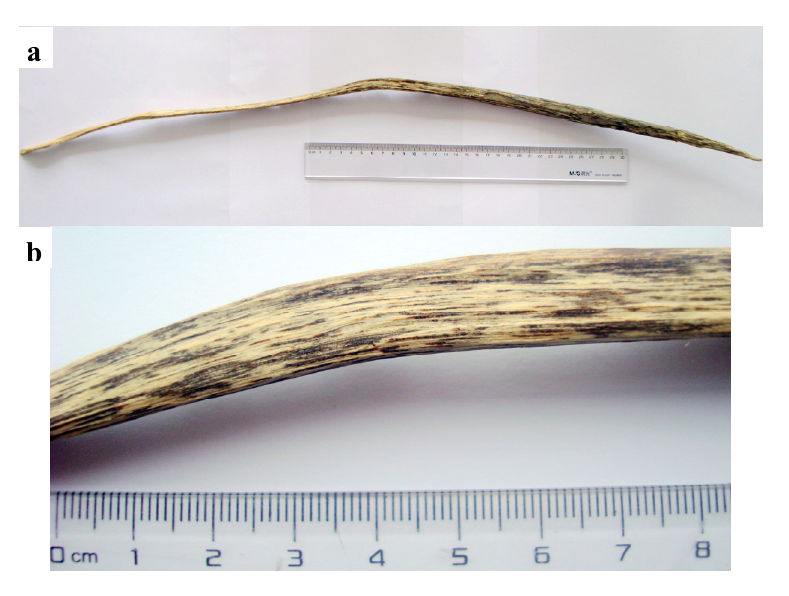
Figure 5. The photo of the artificial agarwood sample. ( a ) The whole piece of the agarwood. ( b ) The partially magnified